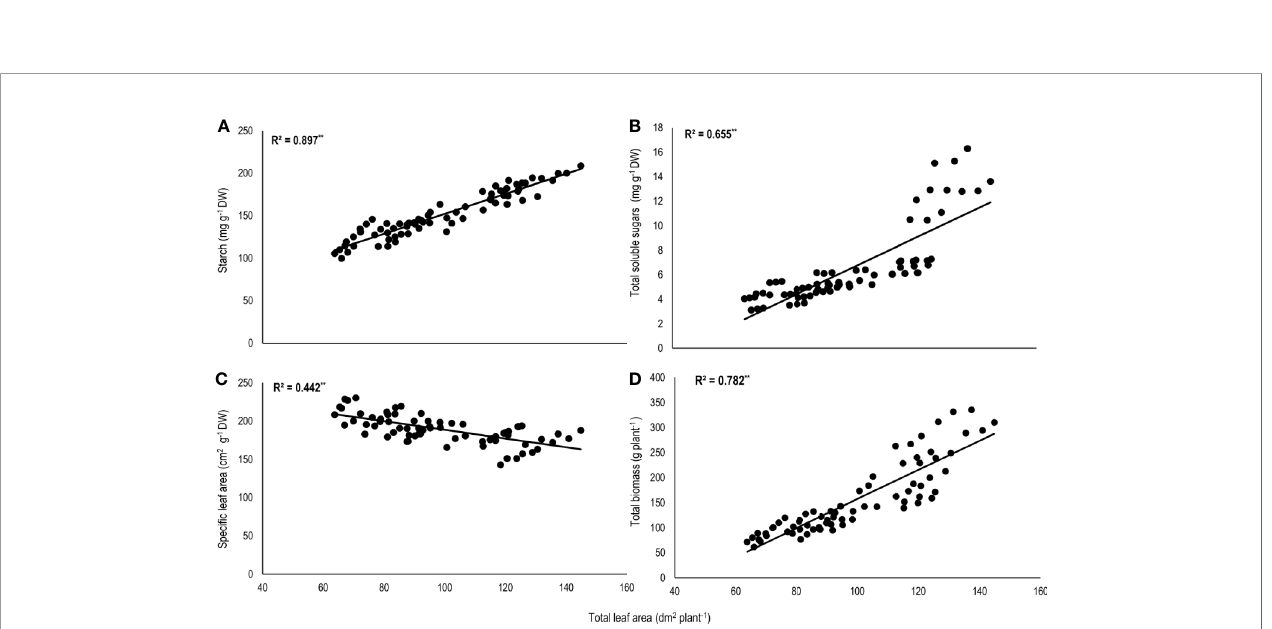
FIGURE 7 | Relationship of total leaf area (TLA) with (A) starch, (B) total soluble sugars (TSS), (C) speci fi c leaf area (SLA), and (D) total biomass (TB) of two sorghum hybrids (DK 53 and DK 28E) exposed to two mean temperatures (27 and 35°C) [27°C (optimum mean daytime and nighttime temperature; ODNT) and 35°C (high mean daytime and nighttime temperature; HDNT)] with three diurnal temperature amplitudes (2, 10, and 18°C). Coef fi cient of determination (R 2 ) followed by ** signi fi cant at P < 0.01. Dry weight